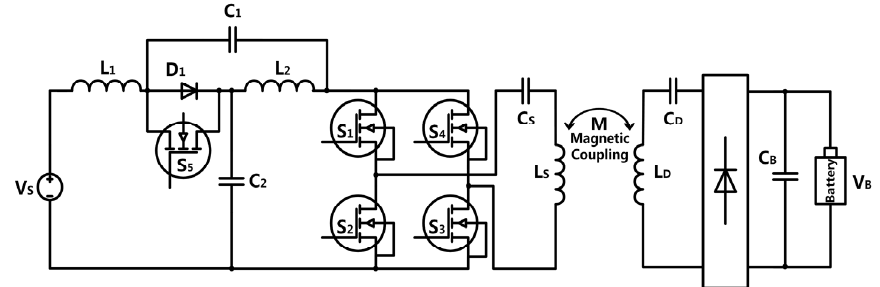
Figure 6. Overall schematic of the wireless power transfer system.